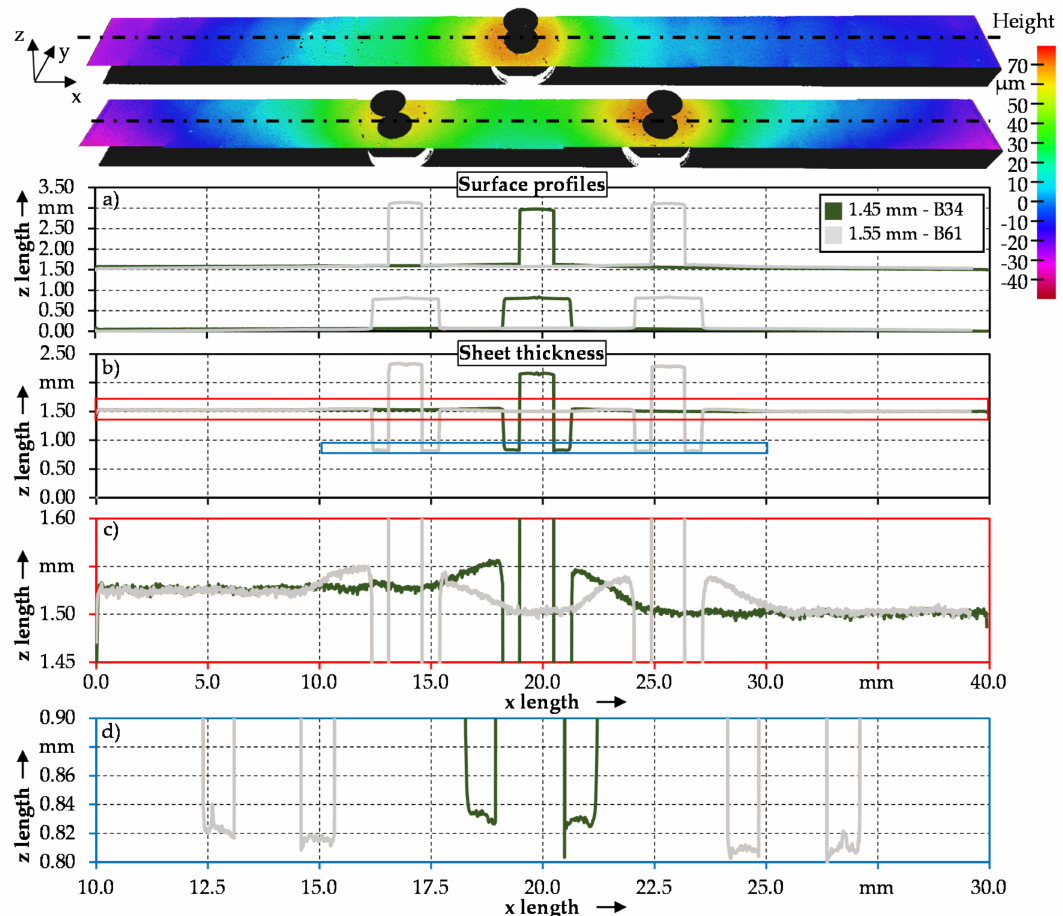
Figure 7. Illustration of the surface profile of a single and multi-pin structure as well as the sheet thickness across the width of the sample. ( a ) Surface profiles of the measured specimens, ( b ) corresponding sheet thickness, ( c ) detailed view of the red area marked in subfigure ( b ) and ( d ) detailed view of the blue area marked in subfigure ( b